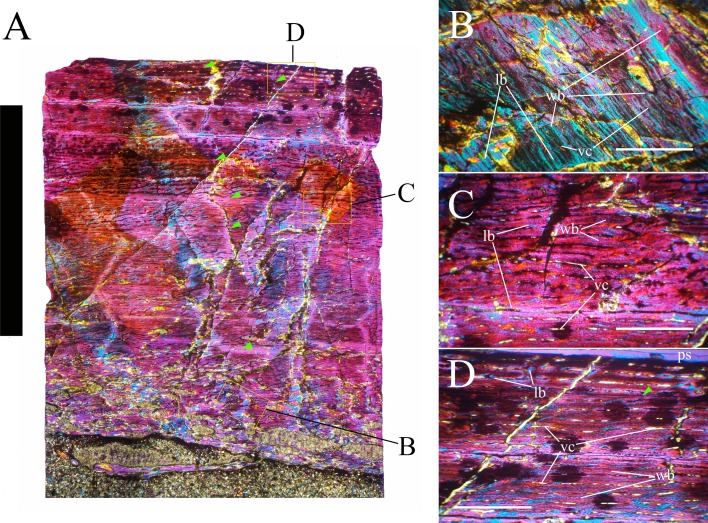
MSNVE 3714, left humerus, thin section.Panoramic view under lambda filter (the outer surface of the bone is at the top of the figure) (A); detail of the progressive transition between the compacta and the medullary cavity, characterized by erosional cavities (B); detail of the fibrolamellar bone and longitudinal vascularization forming the primary bone (C); detail of the microstructure of the outermost cortex showing the absence of an EFS (D); no secondary osteons are observed in the inner cortex. Green arrows point to the LAGs. Abbreviations: lb, lamellar bone; mc, medullary cavity; ps, periosteal surface; vc, vascular canals; wb, woven bone. Scale bars equal 10 mm in A and 1 mm in B–D.